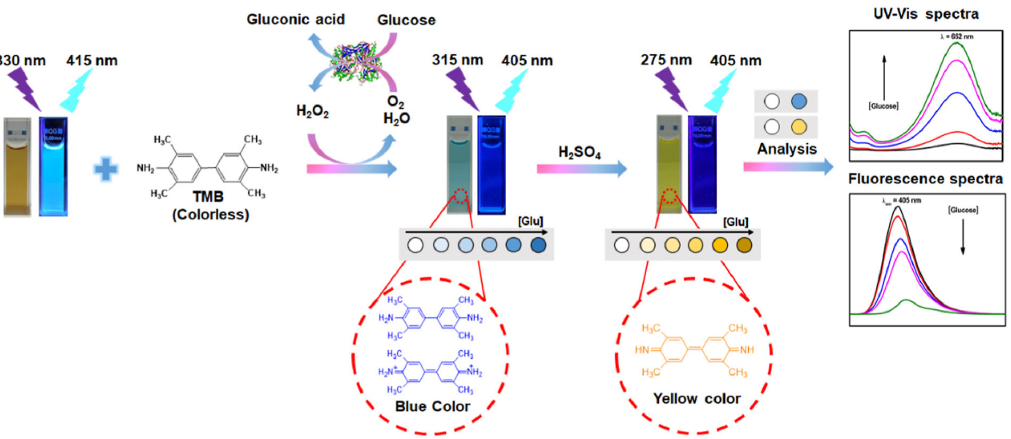
Figure 3. Schematic representation of metal oxide hybrid with N-doped carbon dots for the colorimetric detection of hydrogen peroxide and glucose. Reproduced with the permission of [35]. Copyright 2021, Elsevier.